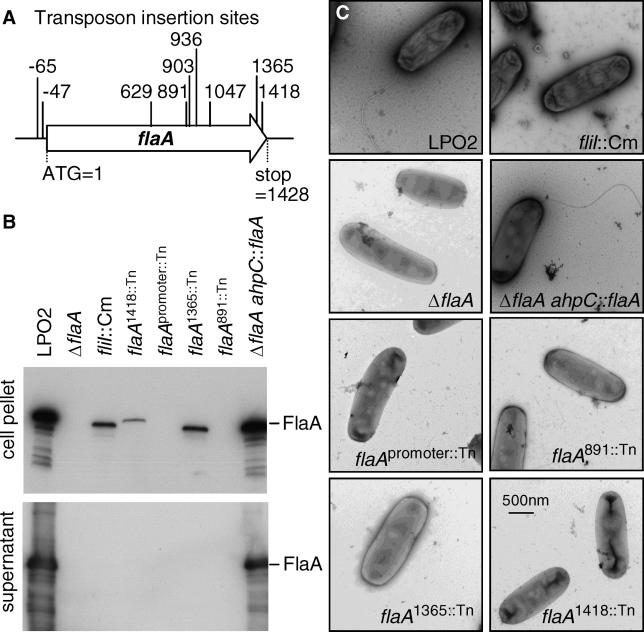
Characterization of Legionella Mutants Harboring Transposon Insertions in Flagellin (flaA)
(A) Nucleotide positions of transposon insertions in flaA.
(B) Western blotting for flagellin (FlaA). Proteins from pelleted bacteria (top) or TCA-precipitated culture supernatants (bottom) obtained from stationary-phase cultures were separated by SDS-PAGE, blotted, and probed with an anti-FlaA monoclonal antibody. ΔflaA ahpC::flaA is the ΔflaA mutant which has been complemented with a copy of flaA inserted on the Legionella chromosome just after the ahpC locus.(C) Electron microscopy showing the presence or absence of flagella on various Legionella strains. Representative bacteria (of >100 surveyed) are shown. No flagellated bacteria were seen for any of the strains shown as lacking flagella.Tn, transposon.